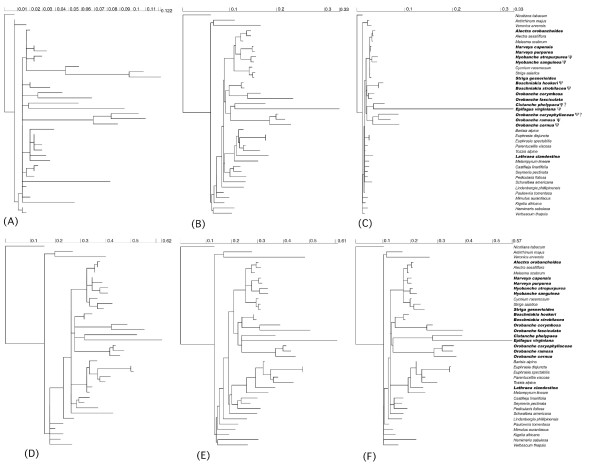
Nonsynonymous and synonymous rates of change in three genes. Nonphotosynthetic taxa are named in bold. (A) rps2 nonsynonymous branch lengths. (B) matK nonsynonymous branch lengths. (C) rbcL nonsynonymous branch lengths. (D) rps2 synonymous branch lengths. (E) matK synonymous branch lengths. (F) rbcL synonymous branch lengths. Taxa with rbcL pseudogenes are identified with Ψ. Uncertain pseudogene status is indicated by "Ψ?" [20, 26].